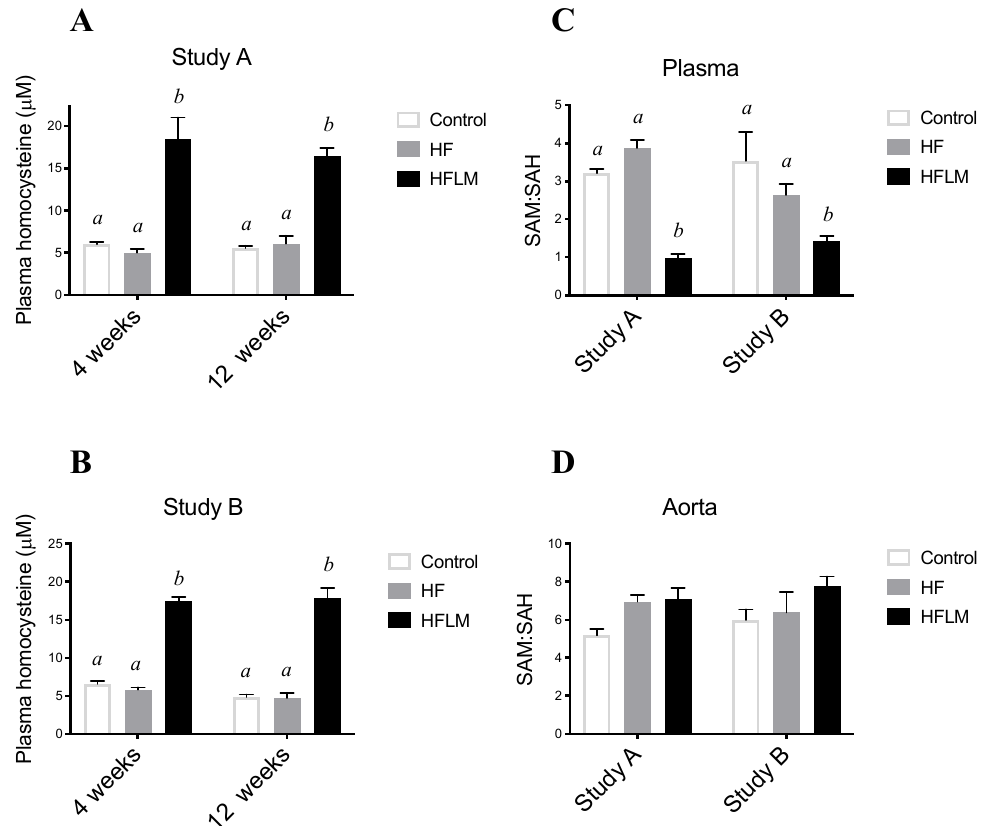
Figure 3. The effect of control, High-Fat (HF), or low in methyl donors (HFLM) diets on plasma tHcy concentrations ( A , B ), plasma SAM:SAH ratio ( C ), and aortic SAM:SAH ratio ( D ). Data shown are the mean ± SEM, n = 5–6/group; bars not sharing not sharing superscript letters differ by p < 0.05. The ratio of SAM concentration divided by SAH concentration was used as an indicator of the methylating capacity, determined in plasma after 8 weeks of diet treatment, and in the aortas after 16 weeks (Study A) or 12 weeks (Study B) of diet treatment. In both studies ( n = 5–6 per study), HFLM mice displayed a significantly lower plasma SAM: SAH ratio, when compared to HF or control mice (Figure 3C). In both studies, plasma SAM: SAH ratios were similar in HF and control mice (Figure 3C). Interestingly, however, the ratio of aortic concentrations of SAM: SAH in HFLM mice did not differ from HF or control mice either after 12 weeks or 16 weeks of diet (Figure 3D), thus showing the absence of an hypomethylating environment in the HFLM aortas.